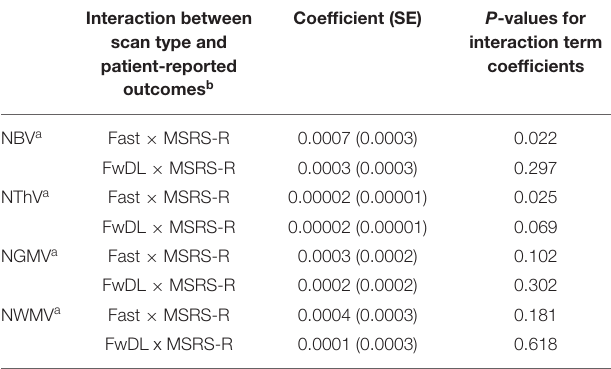
TABLE 4 | Linear mixed-effects model with conventional MRI scans as baseline and interaction with multiple sclerosis symptom burden as measured by MSRS-R. Interaction between scan type and